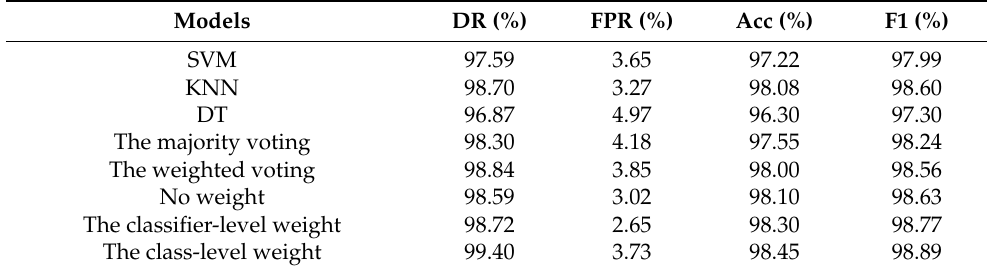
Table 5. Performance comparisons of the base learners and different voting ensemble methods without feature selection on the NSL-KDD dataset.